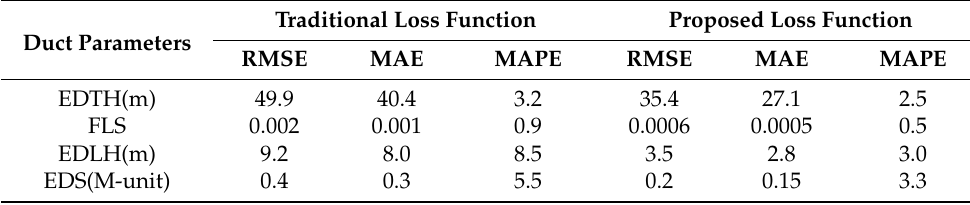
Table 3. Comparison of inversion results based on different loss